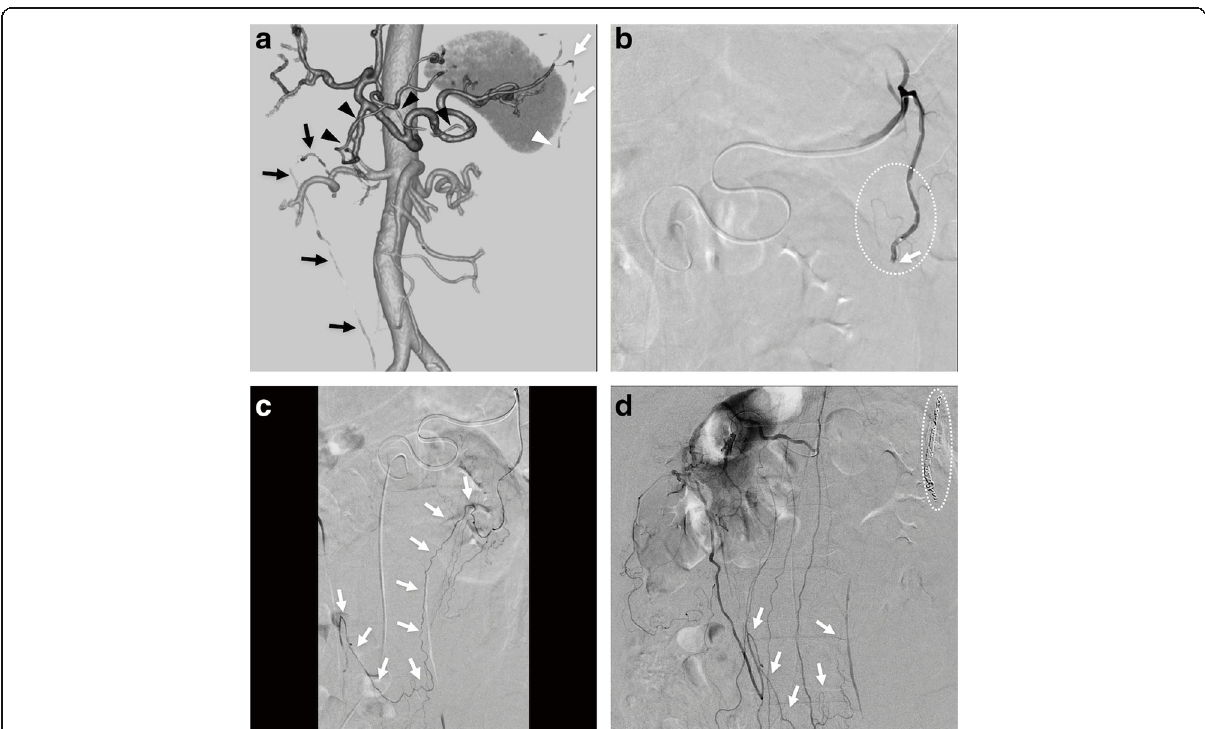
Fig. 2 Images from a 60-year-old man with left OA bleeding associated with SAM. a Coronal volume-rendered computed tomography image in cranial and right-anterior projection reveals that a left OA (white arrows) arises acutely from a splenic artery branch and develops subtle dilation and stenotic change. The distal side of left OA is completely occluded (white arrowhead), presumably associated with SAM. Note that right gastroepiploic artery (black arrowheads) courses alongside the greater curvature of and one of the right omental branches off vertically (black arrows), which is found to be directly communicated with the to-be embolized left OA (white arrows). SAM is the most likely diagnosis, and transarterial embolization is planned. b DSA of left OA in right anterior oblique projection reveals that it acutely arises from a splenic artery and that it develops the dilation and stenotic change (dotted circle) and complete occlusion (arrow). Given that embolization of the proximal left OA at the arrow-indicating point could lead to incomplete hemostasis or rebleeding via arterial collateral network through another OA arising from right gastroepiploic artery, attempt was made to navigate the microcatheter into the distal side beyond the occluded point without complications. c DSA of the distal side of left OA in posteroanterior projection reveals that distal left OA does not develop findings suggestive of SAM. Note that the to-be-embolized left OA directly communicates with a right OA arising from right gastroepiploic artery (arrows). Embolization was successfully performed using isolation technique with coils. d DSA of gastroduodenal artery in posteroanterior projection reveals a right OA (arrows) directly communicating with the embolized left OA, which does not develop any further a potential bleeding point. Note that the SAM- associated left OA (dotted circle) is embolized with metallic coils. Complete hemostasis by isolation technique with coils is